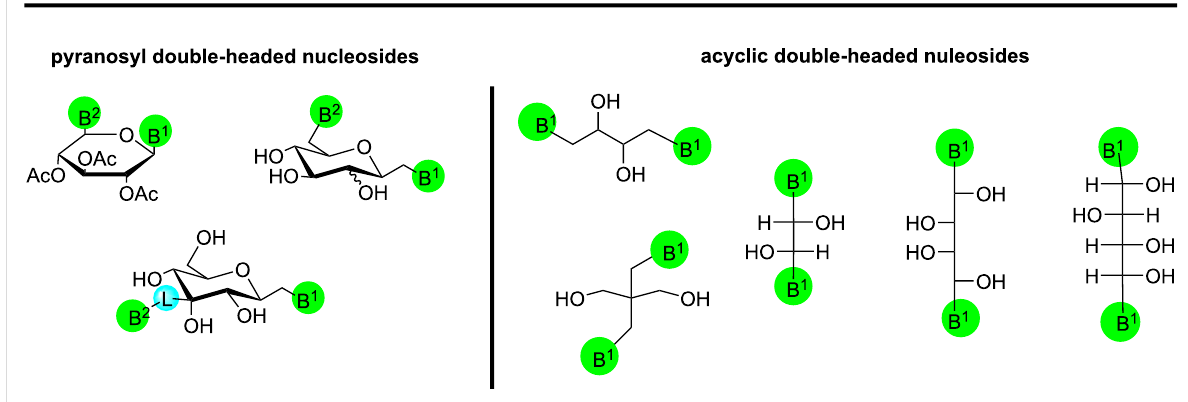
Corey–Chaykovsky epoxidation [41] of 2 ′ -ketonucloside 1 with trimethylsulfoxonium iodide in DMSO afforded the spironucle- oside 2 , which in turn was converted to the TIPDS-protected 2 ′ -(pyrimidin-1-yl)methyl-/2 ′ -(purin-9-yl)methylarabinofura- nosyluracil derivatives 3a–f by nucleophilic epoxide ring opening with thymine, N -benzoyladenine, 6- O -allyl- N -isobu- tyrylguanine, N -benzoylcytosine, 6- O -allylhypoxanthine or N , N -dibenzoyldiaminopurine in 53 to 83% yield. The desilyl- ation of the nucleosides 3a – f with tetrabutylammonium fluo- ride in tetrahydrofuran (THF) led to the formation of six differ- ent double-headed nucleosides 4a – f (Scheme 1) [38,39].